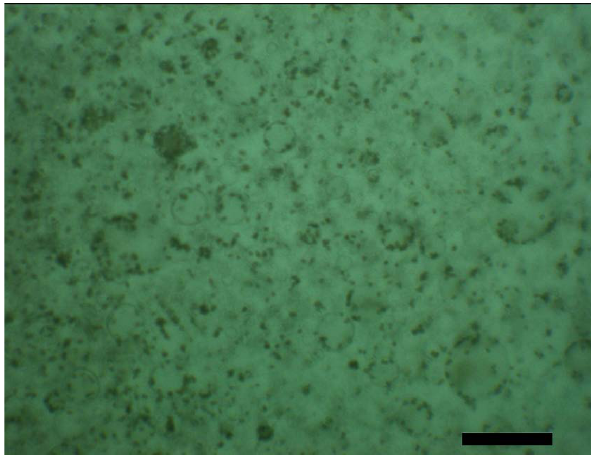
Fig. 2. A capture of an emulsion spiked with Agaricus bisporus avellaneous spores. The bar represents a length of 150µm. It shows that spores are present in both the droplets and in the oil